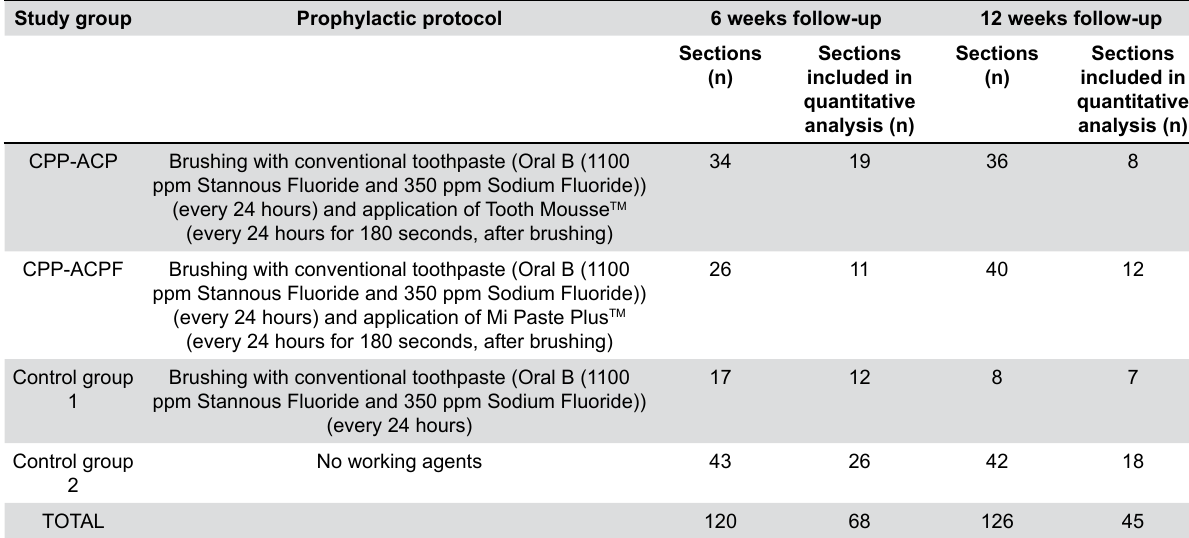
Table 1- Prophylactic protocol and descriptive statistics of the study